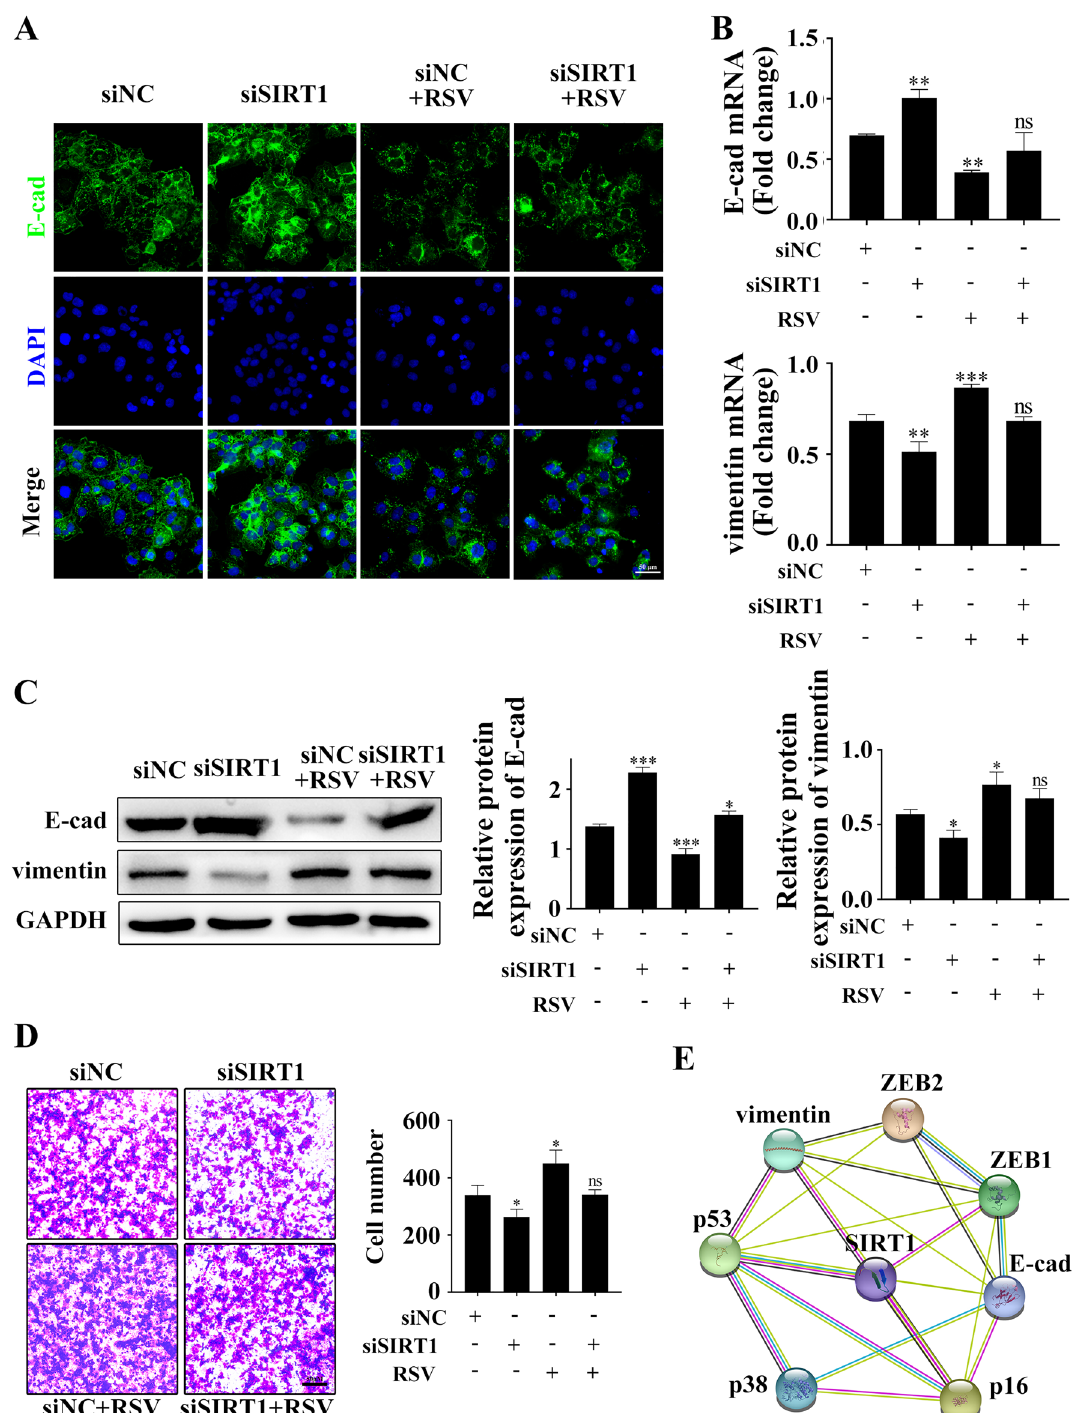
Figure 7. Effect of RSV on the EMT of Ishikawa cells . Ishikawa cells were treated with siNC or siSIRT1 with or without RSV, and then E-cad protein levels were examined by immunofluorescence staining ( A ). E-cad and vimentin mRNA or protein levels were examined by qPCR ( B ) and western blotting ( C ). Matrigel invasion assays to determine the invasive properties of the cells from the parallel cell cultures ( D ). The bioinformatics analysis depicting the correlation between SIRT1, ECM and senescence was mapped with the STRING database to construct a PPI network ( E ). Scale bars = 50 µm in ( A ). RSV resveratrol, E-cad E-cadherin. * p < 0.05, ** p < 0.01, *** p <